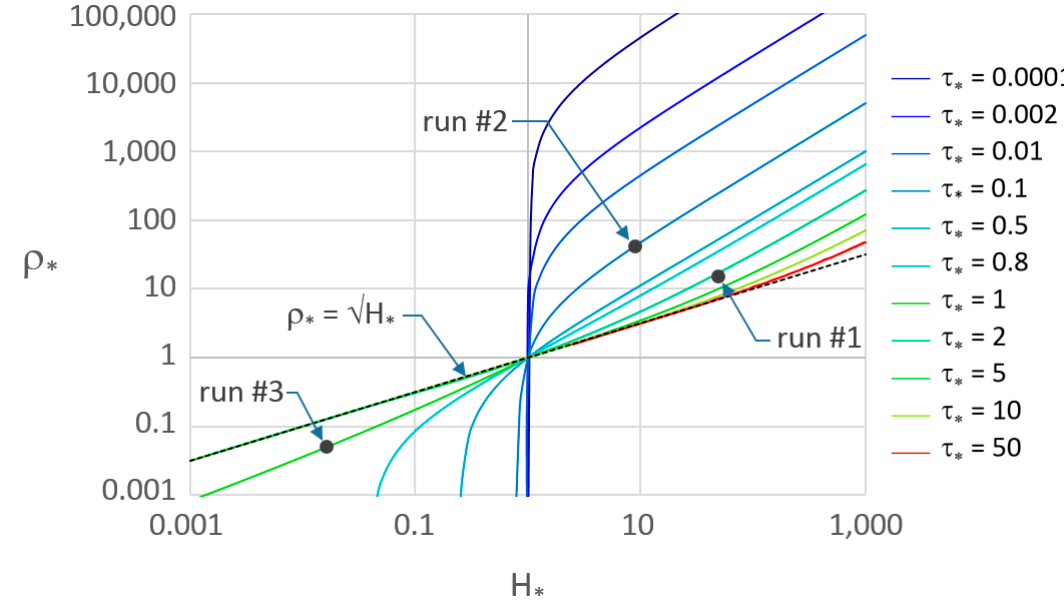
Figure 4. Dimensionless group ρ * , depending on the runoff intensity, versus the dimensionless group H * = h * / h *0 , with the normalized time step, τ * , as a parameter. The figure also plots the equation ρ * = √ H * , denoting the limiting condition.